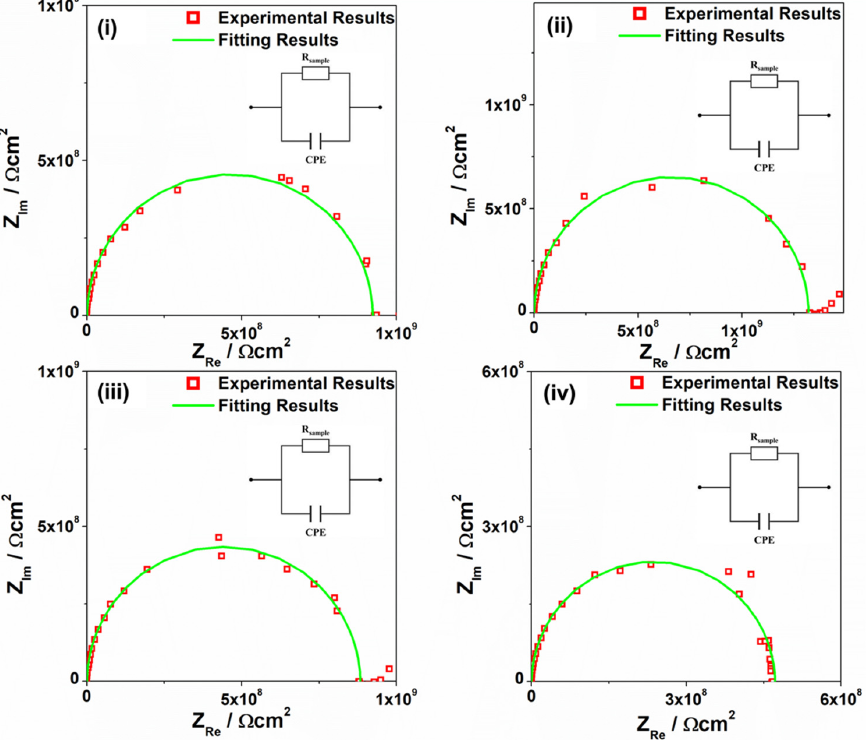
Figure 7. EIS spectra of A(170)_ 3a OIH sol–gel matrices: ( i ) A(170)_ 3a @500; ( ii ) A(170)_ 3a @600; ( iii )